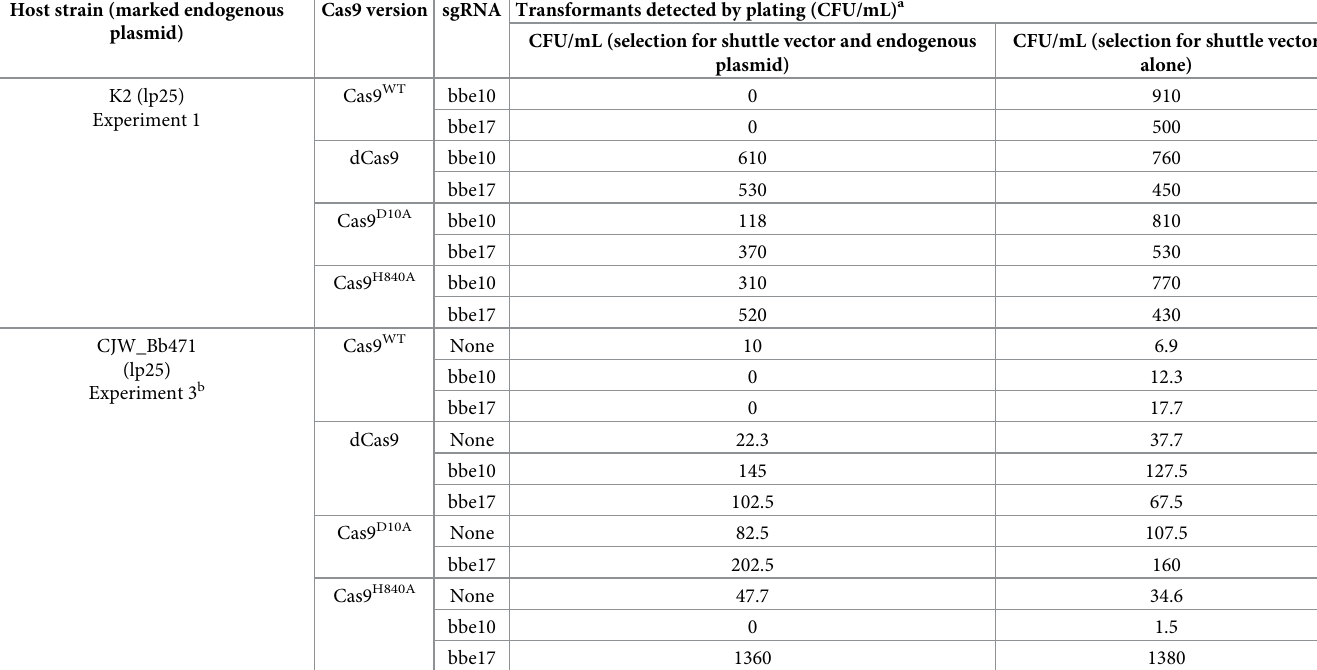
Table 5. Linear plasmid 25 (lp25) retention in B . burgdorferi following Cas9 targeting, as detected by plating. Host strain (marked endogenous Cas9 version sgRNA Transformants detected by plating (CFU/mL) a plasmid) CFU/mL (selection for shuttle vector and endogenous CFU/mL (selection for shuttle vector plasmid)